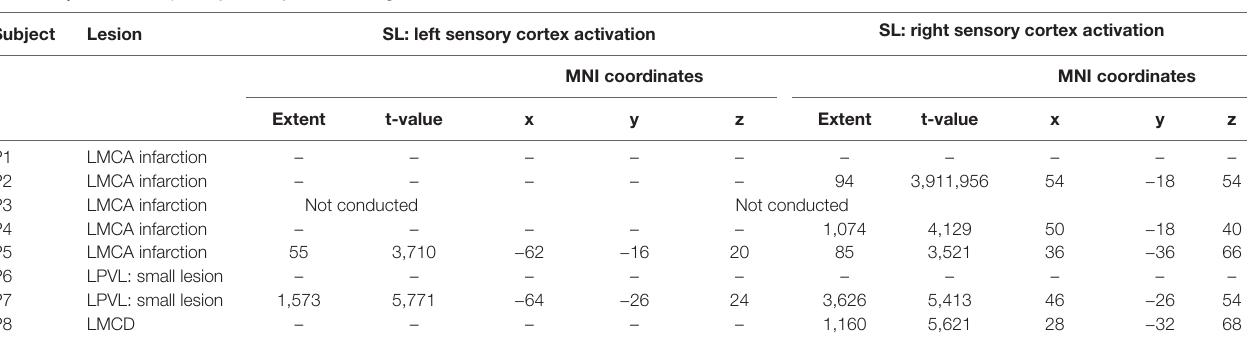
TABlE 5 | Activation in primary sensory cortex during SL